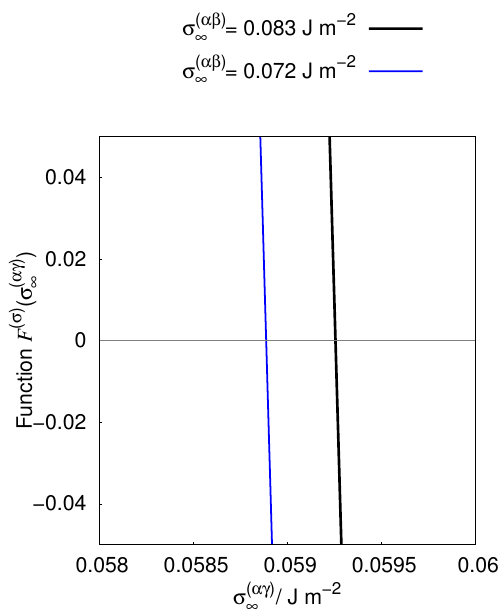
Figure 11. Function F (σ) dependent on the solution/solute inter- facial energy σ (αγ) ∞ according to Eq. (7), employing the “ideal so- lution” limit of the activity model for two different σ (αβ) ∞ values.